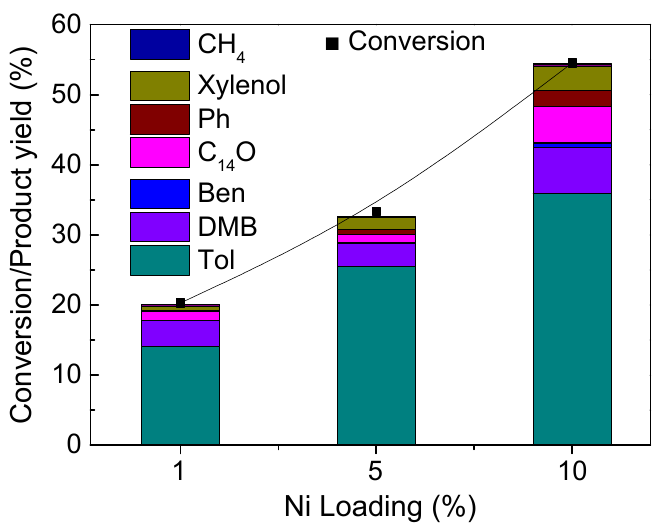
in Ni particle size from 1Ni/r-TiO 2 to 10Ni/r-TiO 2 (Figure 8B-D). The formation of DMB is completed through the hydrogenation of m-cresol on Ni to methylcyclohexanone (MCHone) and methylcyclohexanol (MCHol), which condense to 5,5´-dimethyl-3-hy- droxybiphenyl (C 14 O) on the acid site and then subsequently deoxygenate to DMB (see Figure 7. m-Cresol conversion and major product yields with varying Ni loadings on r-TiO 2 . Reaction conditions: T = 350 ◦ C, P = 1 atm, H 2 /m-cresol = 50, TOS = 30 min, W/F=2 h. Product with a yield of less than 0.2% is not listed. Ben, Tol, Ph, DMB, and C 14 O represent benzene, toluene, phenol, dimethylbiphenyl, and 5,5 ´ -dimethyl-3-hydroxybiphenyl, respectively.